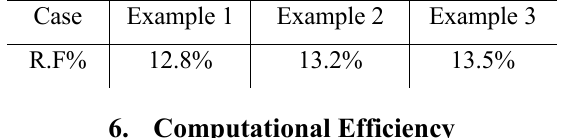
Table :. The impact of disperssion of soil on the R.F% for the different grounding grids.